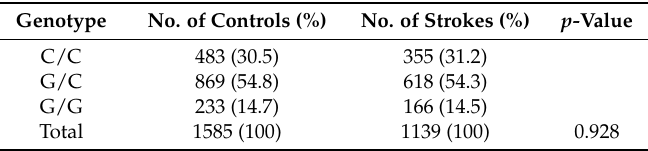
Table 2. Genotype and allele frequencies of